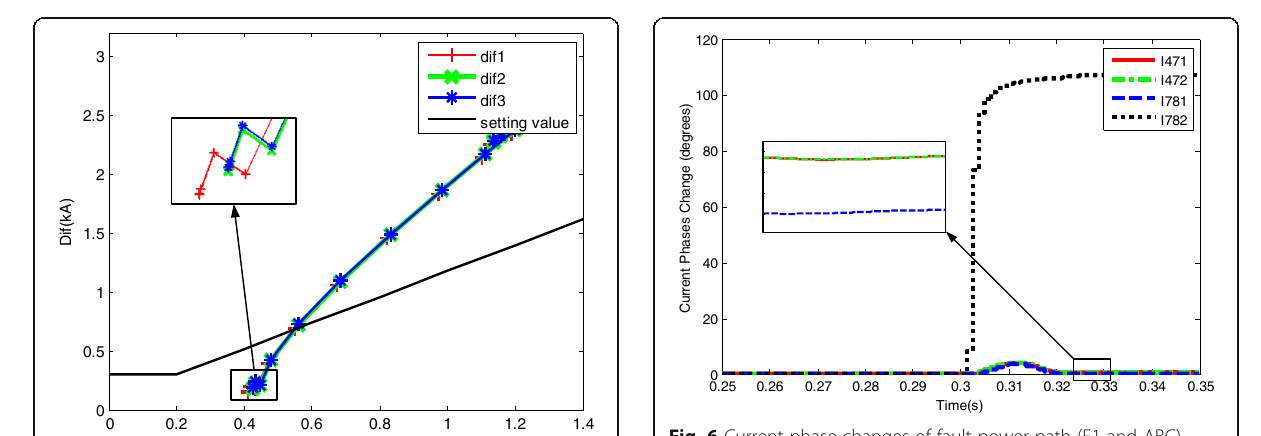
Fig. 6 Current phase changes of fault power path (F1 and ABC)